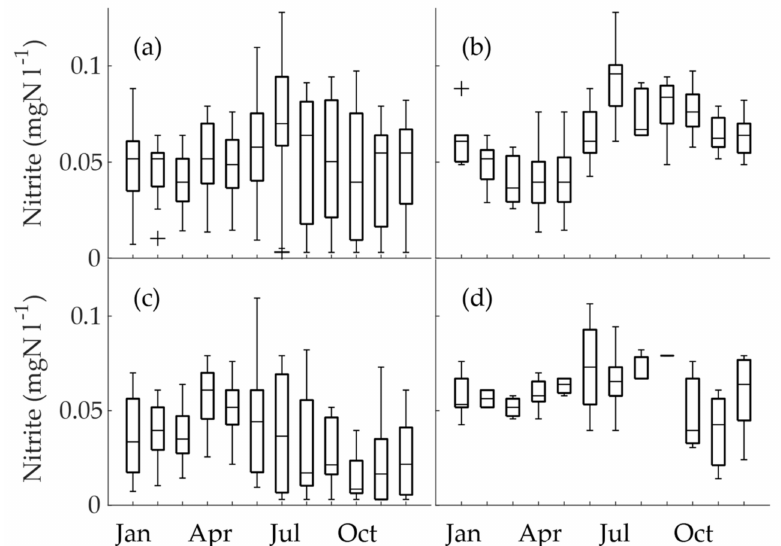
Figure 6. The monthly boxplots of nitrite seasonality in obligatory monitoring data for ( a ) all of the time series (excluding Hospital K, N = 317), ( b ) the time series with the summer maximum ( N = 129), ( c ) the time series with the winter maximum ( N = 143), and ( d ) the time series with mixed seasonality ( N =